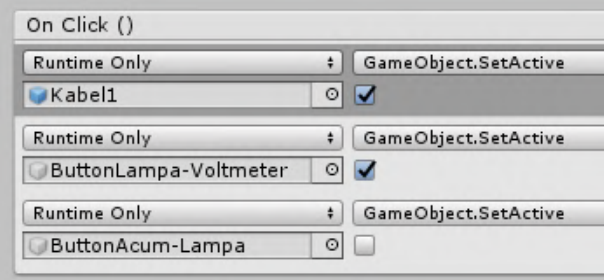
Figure 13: Button settings to connect the connecting wires to